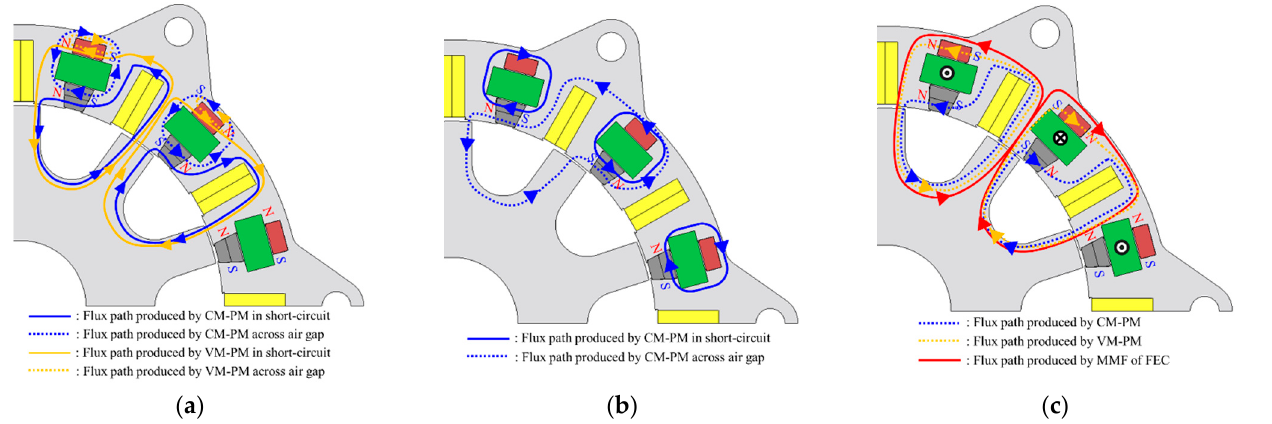
Figure 7. Flux paths of the newly designed HEFSM with VM-PM. ( a ) under no FEC excitation and strengthened magnetization state of VM-PM; ( b ) under no FEC excitation and weakened magnetization state of VM-PM; ( c ) under FEC excitation and strengthened magnetization state of VM-PM. ©2020 IEEE. Reprinted with permission, from K. Otsuka, T. Okada,